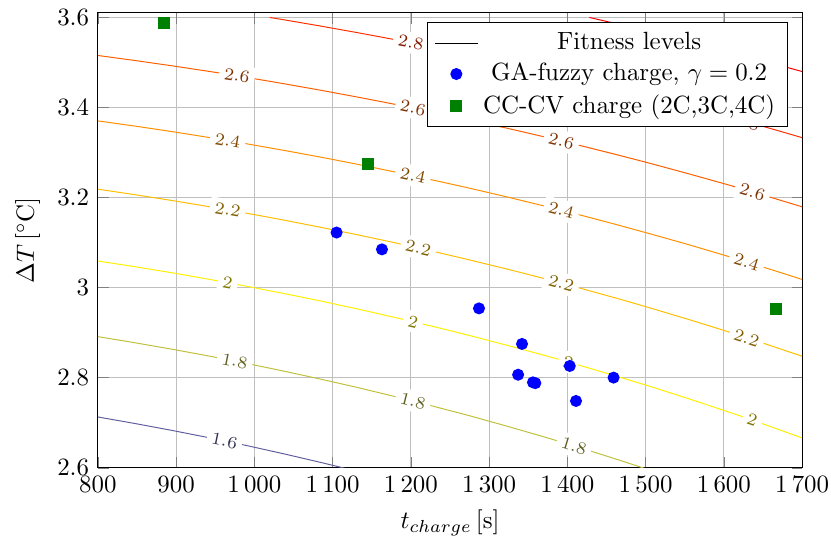
∆ T plane for γ = 0.2. −